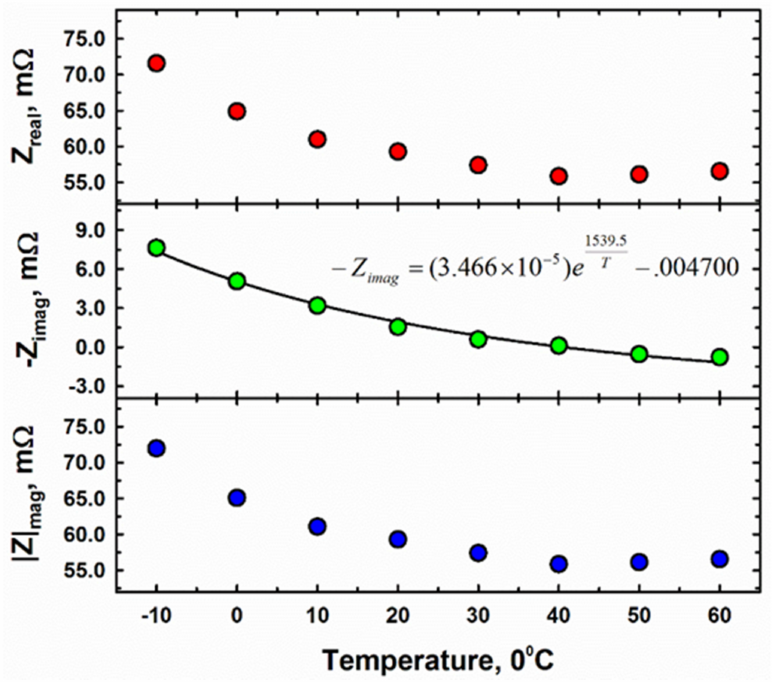
Figure 4. Temperature effects on the real and imaginary components of the impedance at f SOH . An empirical relationship is given for imaginary impedance, − Z imag , as a function of